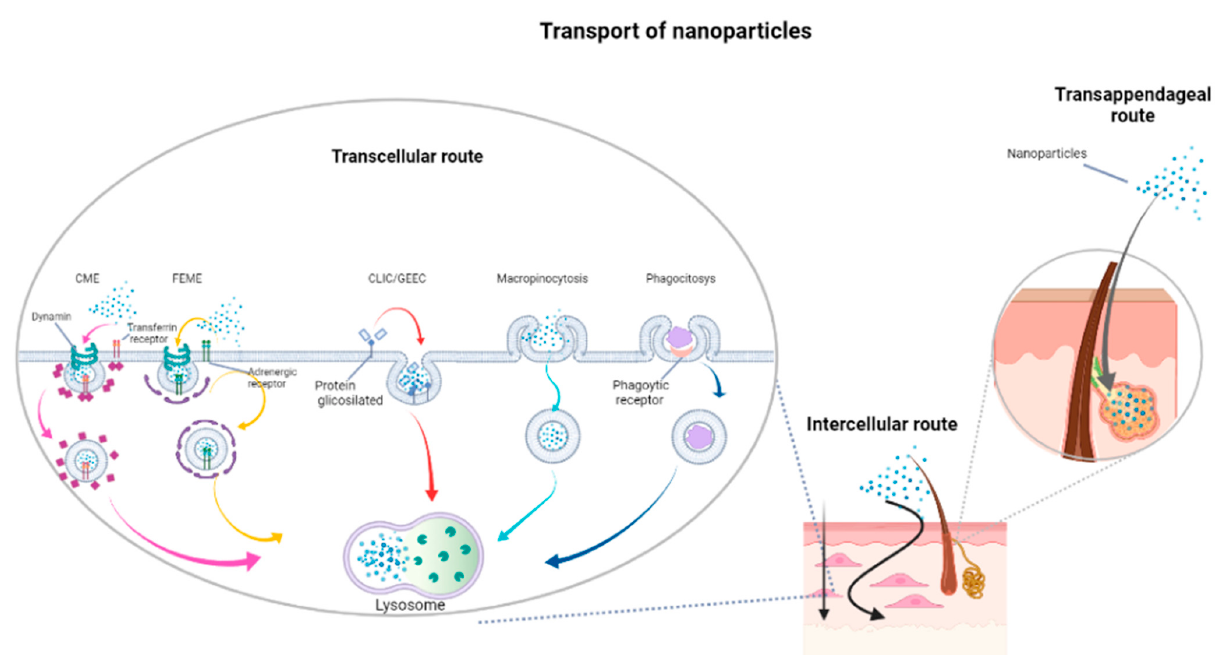
Figure 1. Schematic representation of the three pathways involved in the internalization of molecules through the skin. The image comprises trans-appendageal route, intercellular route and transcellular route. The transcellular route representation is inspired by Rennick et al. [32].